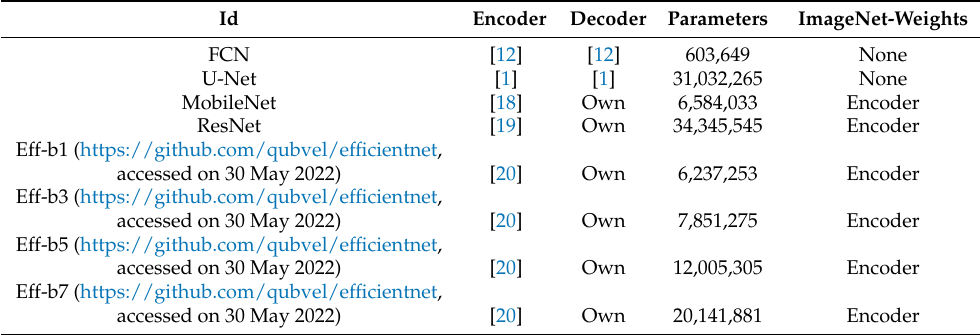
Table 2. Overview of the evaluated architectures. For each architecture, the publication is cited that describes it. Some architectures have been expanded to include a decoder part so that they reflect a U-Net. In addition, the number of parameters is specified and states whether there were pre-trained weights for the encoder part available.